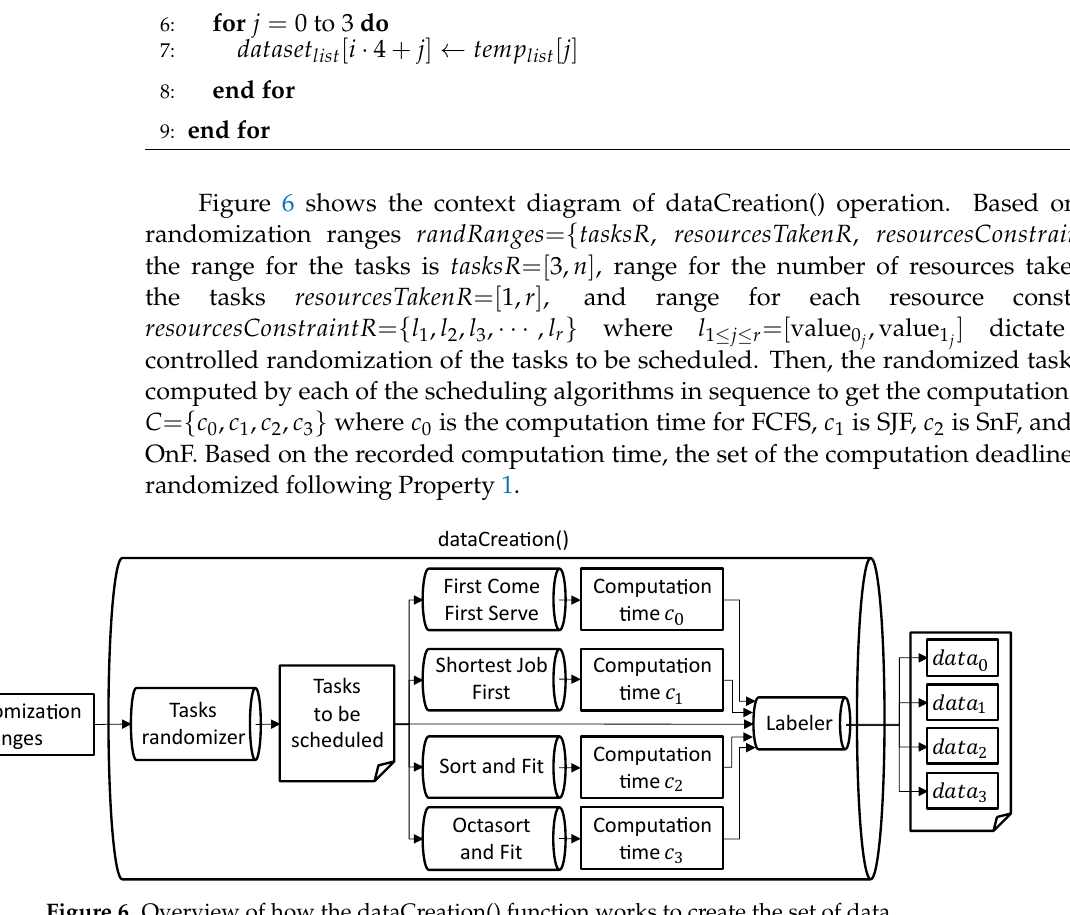
Figure 6. Overview of how the dataCreation() function works to create the set of data. Property 1 (Set of computation deadline D )